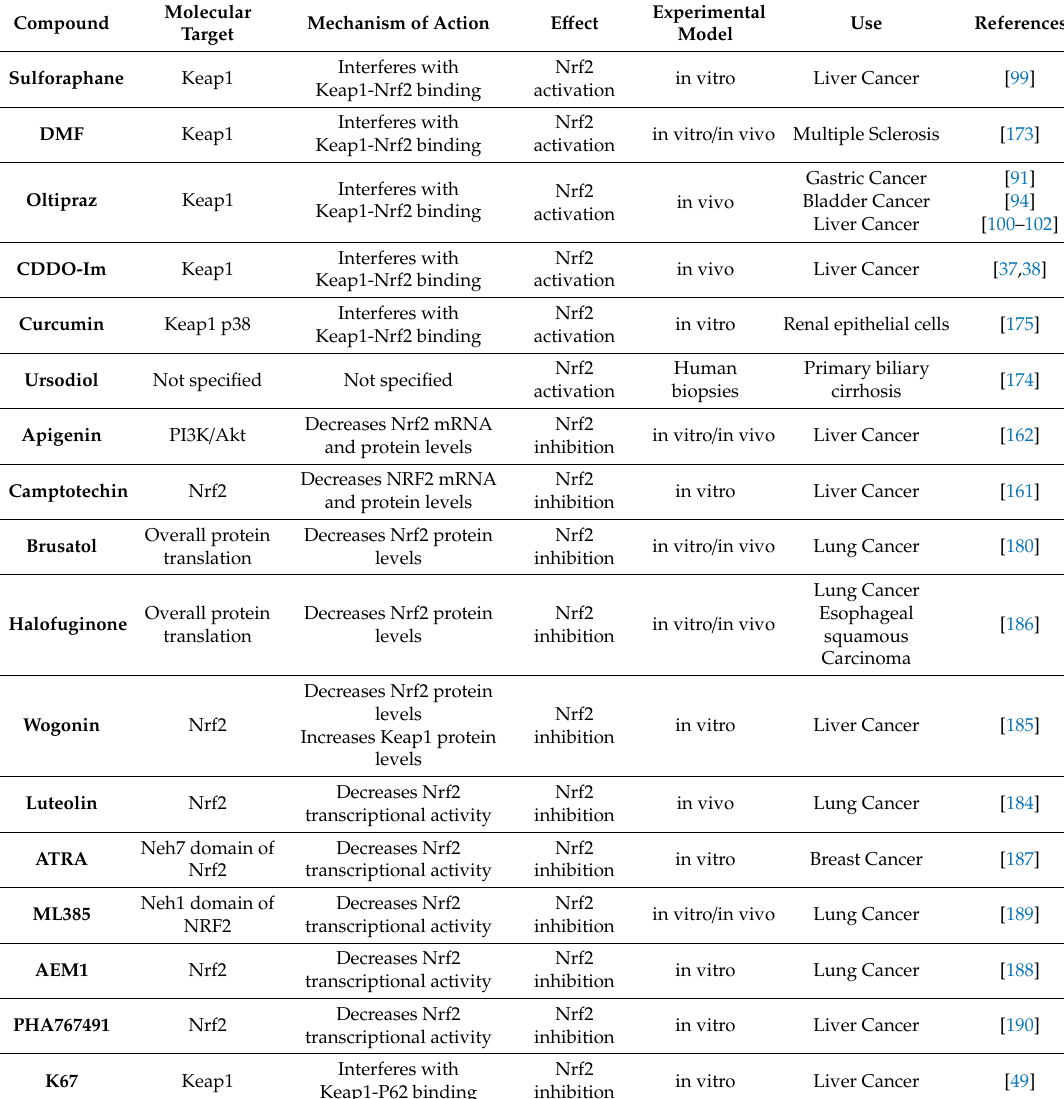
Table 1. Compounds targeting the Keap1 / Nrf2